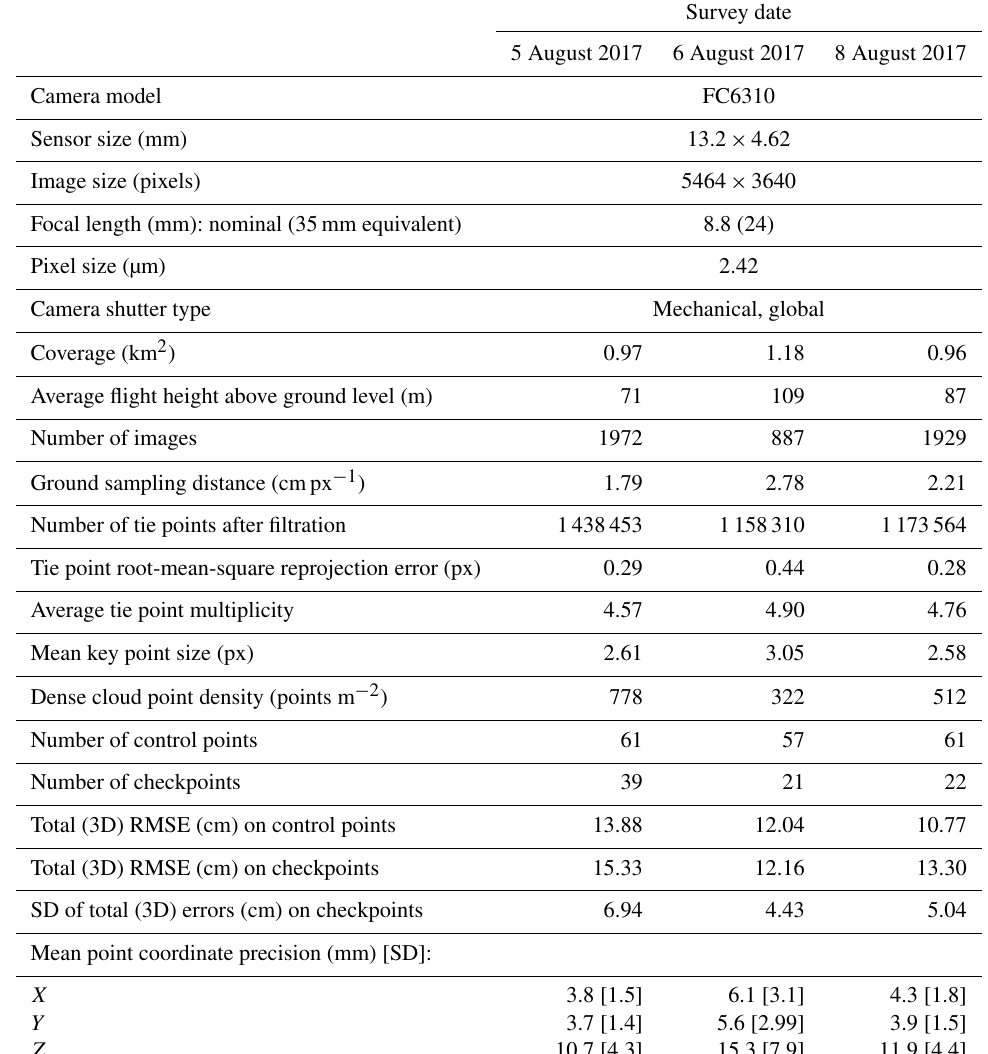
Table 1. Outline of UAV surveys’ parameters, processing errors, and final products’ characteristics following the guidelines suggested by James et al.